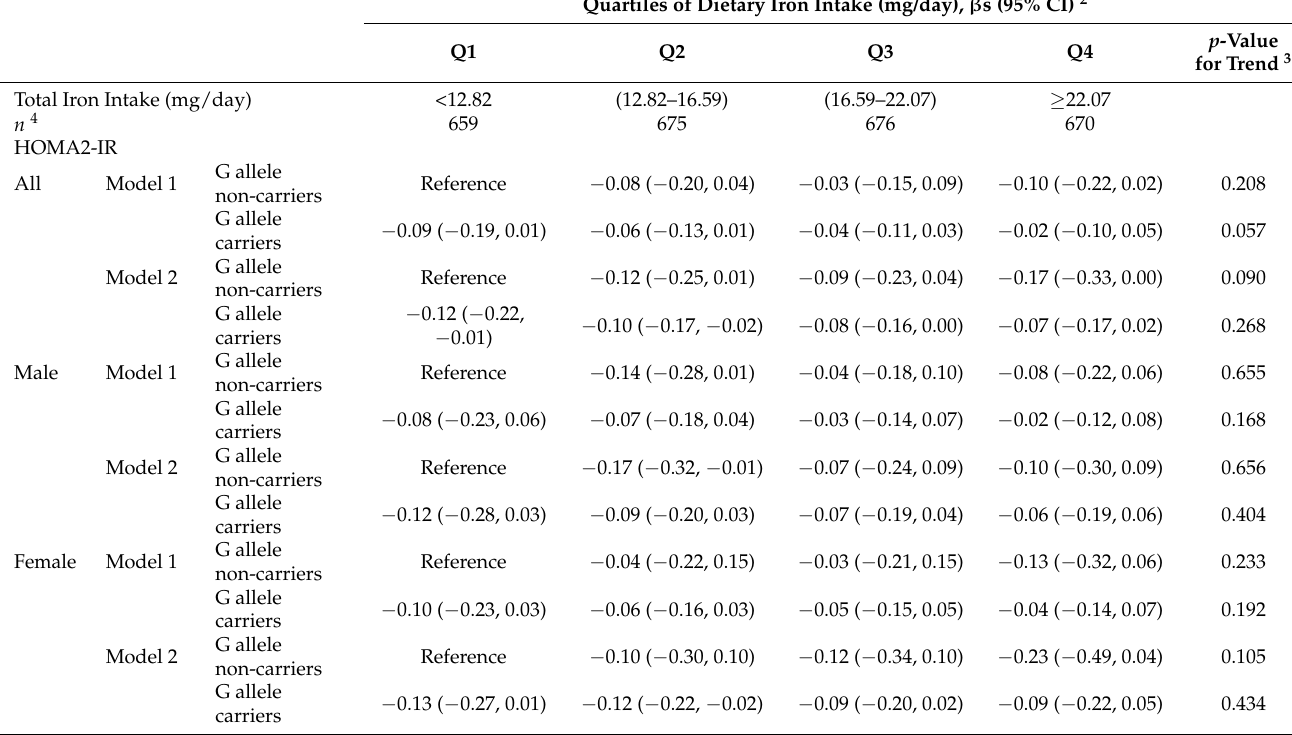
Table 6. β s (95% CI) for HOMA2-IR according to the quartiles of dietary iron stratified by the rs10830963 risk allele in the MTNR1B gene among the participants 1